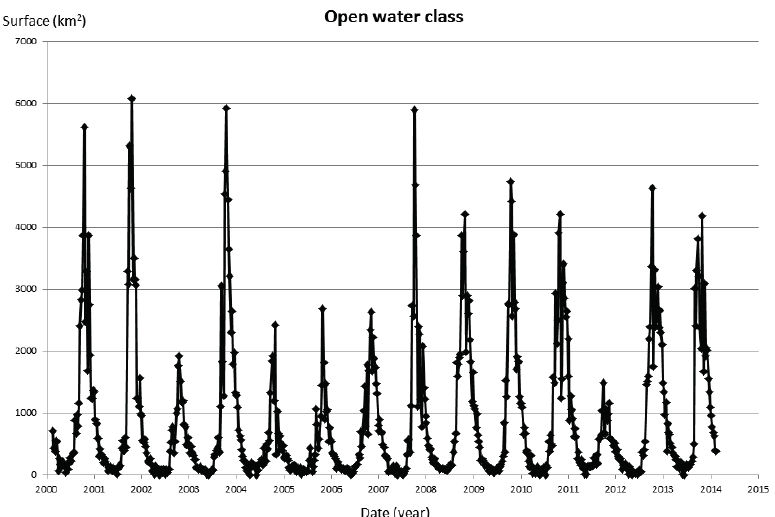
Figure 7. Time series of surface extent of open water class calculated from MODIS data.